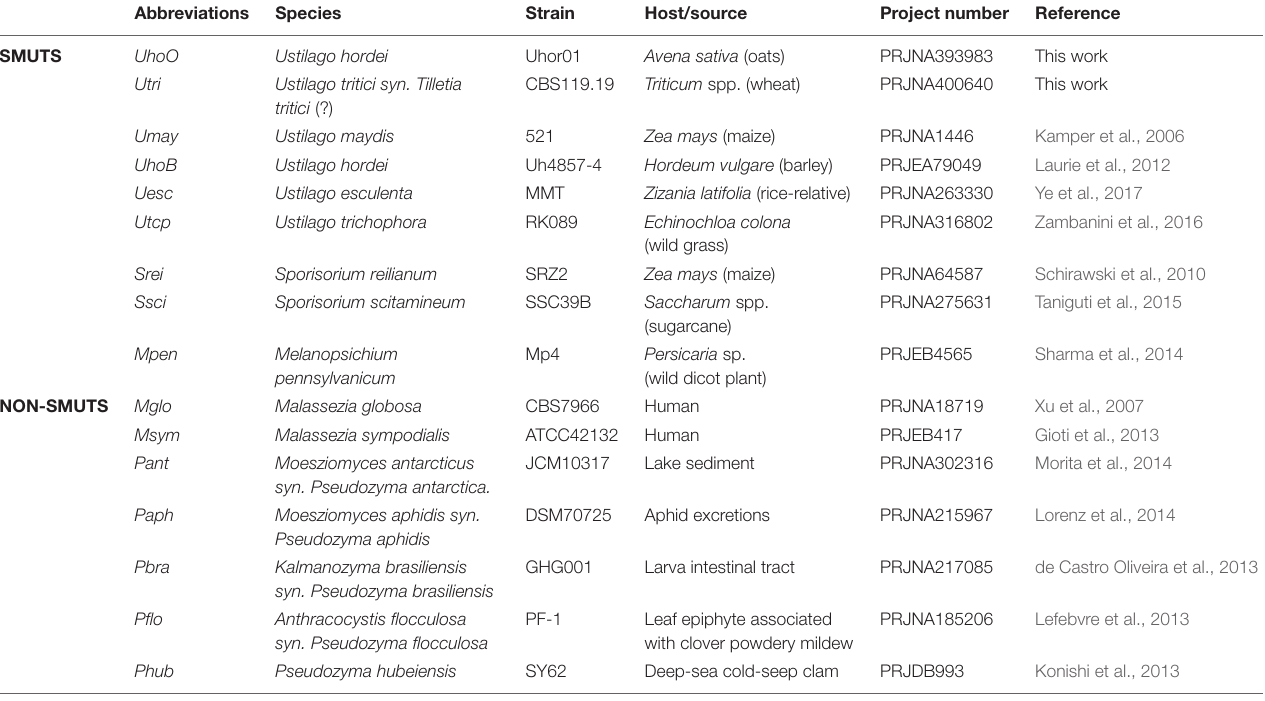
TABLE 1 | List of analyzed Ustilaginomycotina species, strains, and genomes